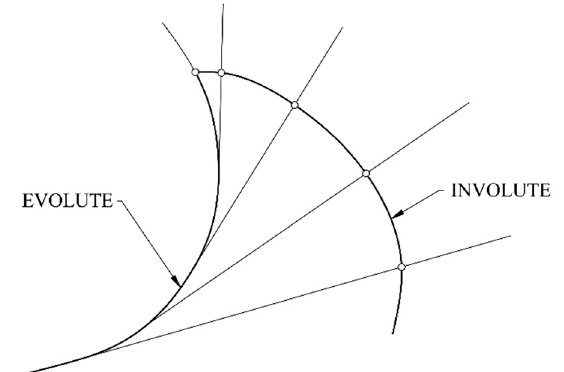
Figure 6. Involute, evolute.